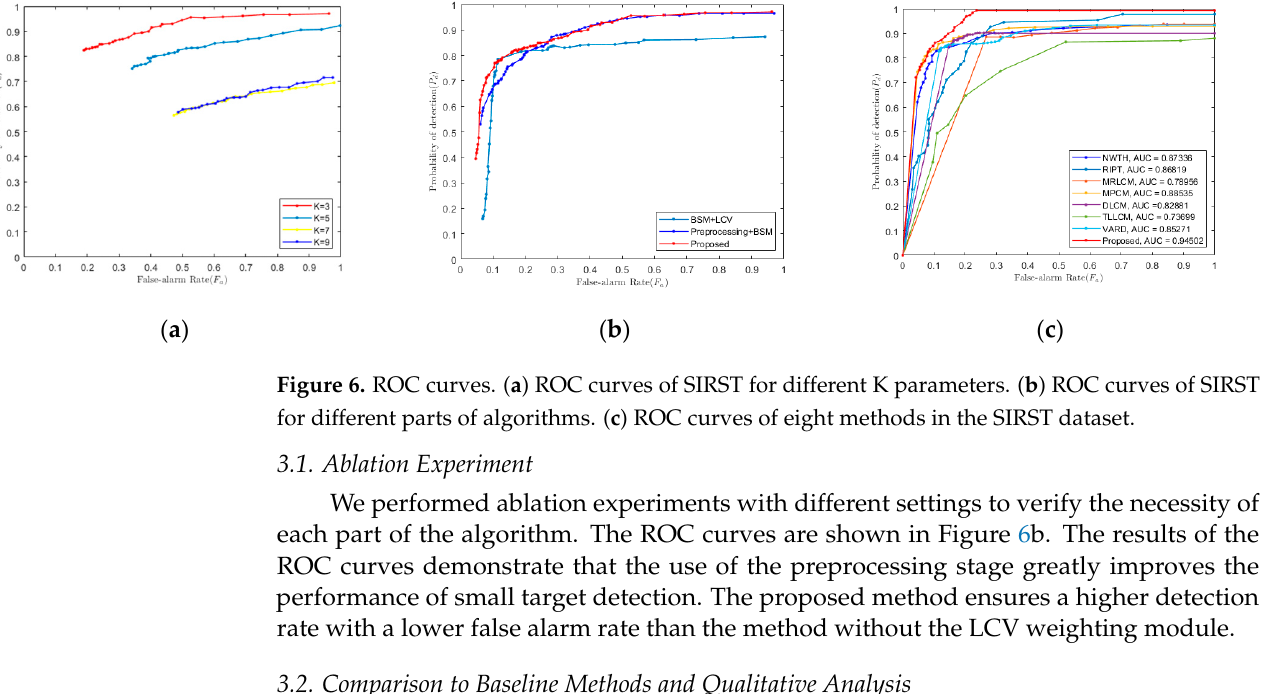
Table 1. Parameter values used in the algorithms. No.